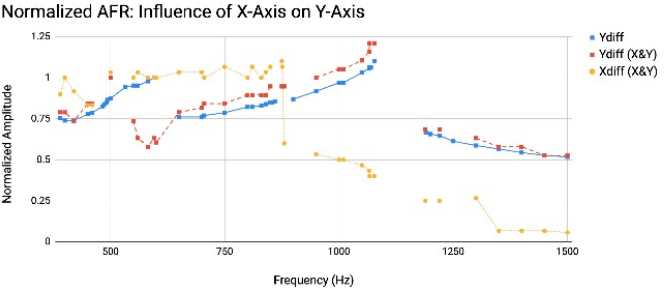
Figure 7. Crosstalk effect on amplitude frequency response (AFR) behavior of y -axis, most notably at secondary amplitude response peak evident at 650.0 Hz for the Y diff output signal when the y -axis is driven without driving the x -axis (blue), versus the amplitude minimum at 650.0Hz (red) when the x -axis (orange) is driven simultaneously.